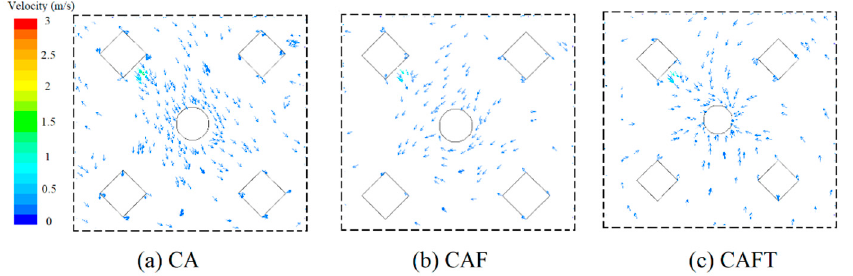
Figure 7. The velocity vector of airflow near the infected occupant under different ventilation con- ditions (Z = 1.1 m).